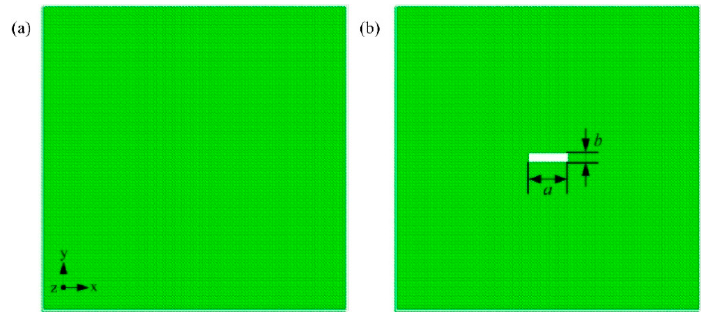
Figure 5. ( a ) The pure aluminum model with the size of 20.25 × 20.25 × 2.43 nm 3 ; ( b ) The model with central crack. The length of the initial crack a = 2.83 nm, and the width b = 0.81 nm.